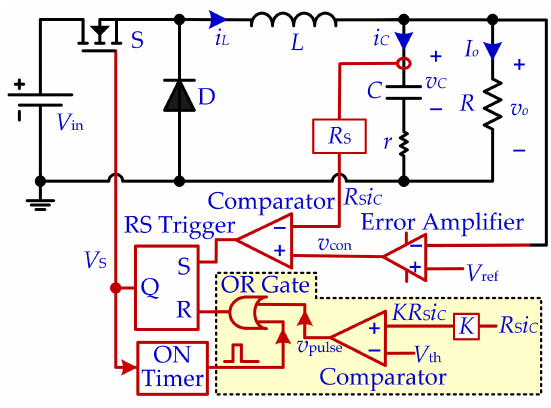
Figure 6. Schematic diagram of the improved CC-COT-controlled buck